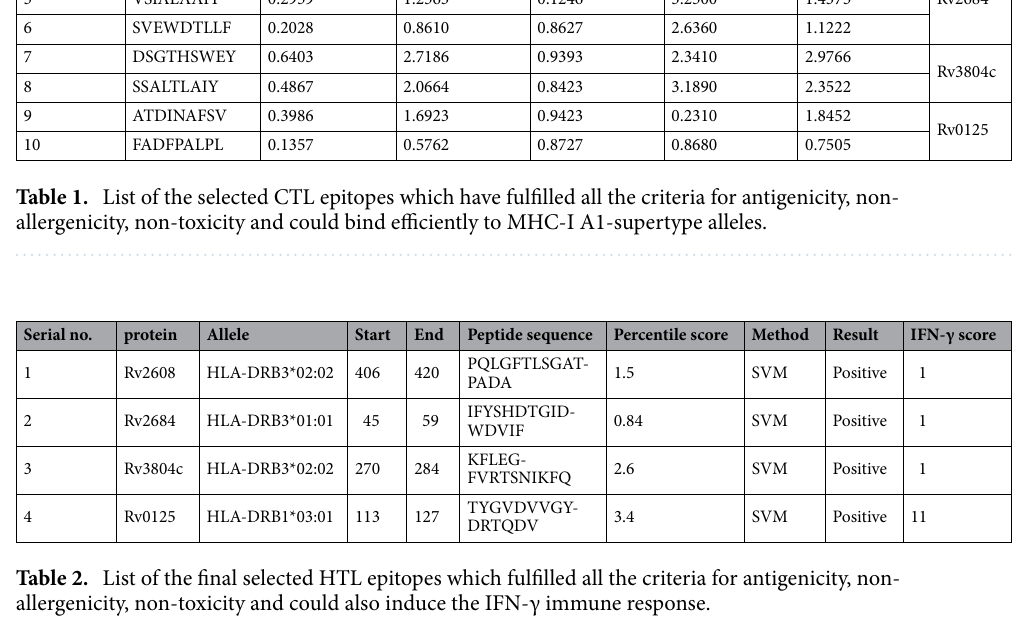
Table 2. List of the final selected HTL epitopes which fulfilled all the criteria for antigenicity, non- allergenicity, non-toxicity and could also induce the IFN-γ immune response.